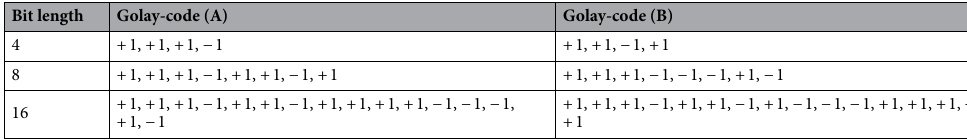
Table 2. Golay-code with different bit lengths.